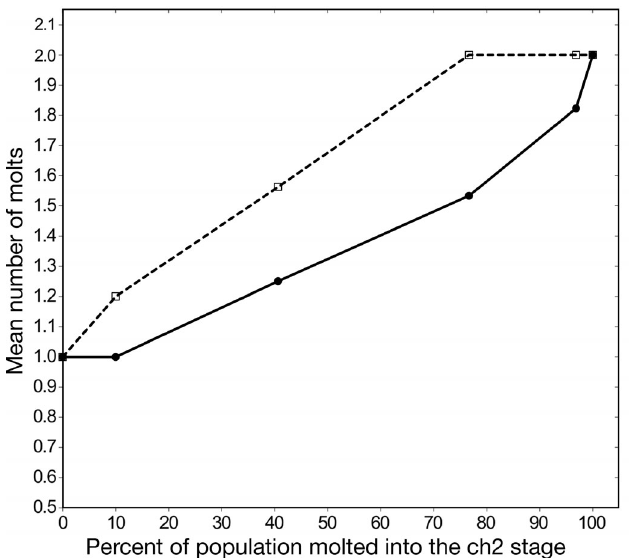
infectionFig. 1. Mean number of molts for male ( h ) and female ( j ) Lepeophtheirus salmonis as a function of the percent of the population that has entered the chalimus II stage. Graph is based on data presented in Table